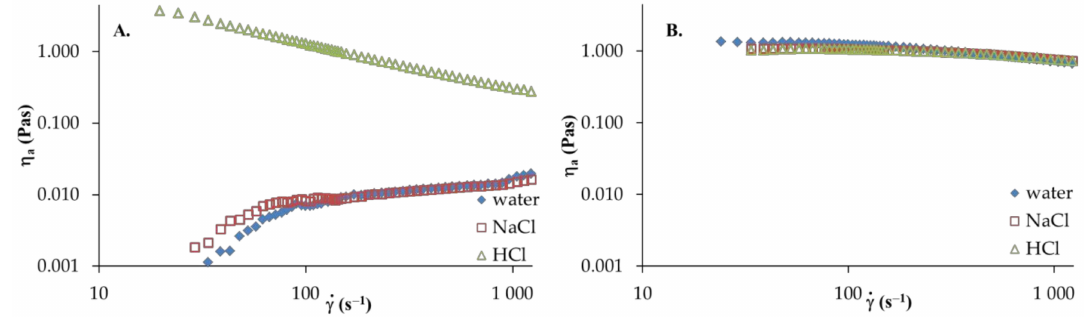
. γ of HA and PVA: ( A ) HA and ( B ) PVA, T = 25